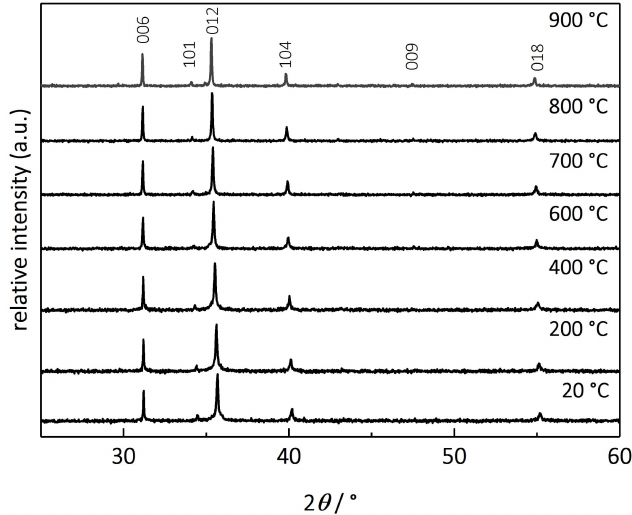
Figure 5. High-temperature X-ray diffraction patterns of CuFeO 2 , measured in nitrogen at discrete temperature levels as indicated.